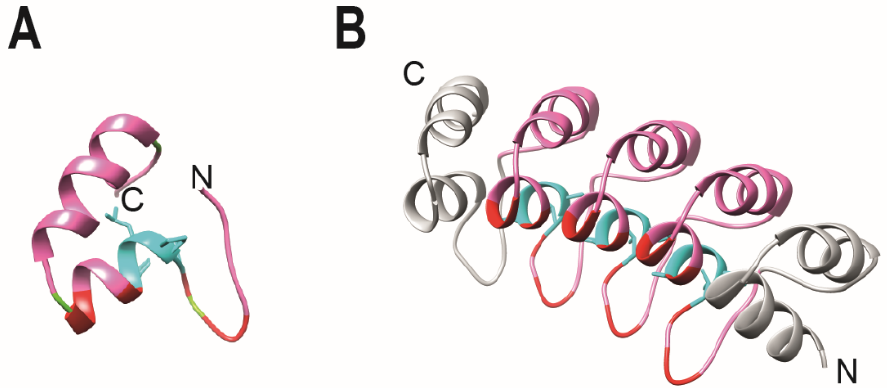
Figure 3. Structure of a monoDARPin domain. ( A ) Library module. The library module is colored in pink, with the conserved TPLH residues in cyan. Residues then can be randomized are indicated in red. ( B ) Homology model of monovalent DARPin R2 generated by SWISS MODEL (SIB) using the consensus designed ankyrin repeat domain PDB ID 2xee and the sequence of mono DARPin R2 [39]. The N-cap and C-cap are colored in grey.